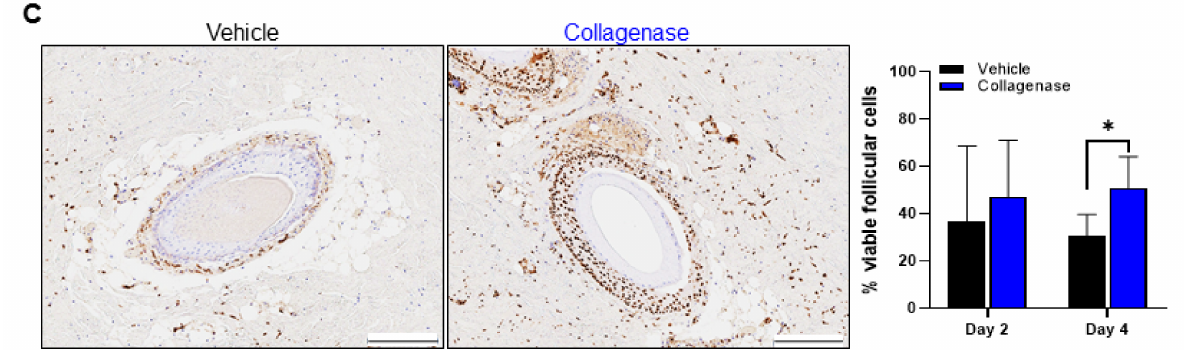
Figure 3. Collagenase-treated burns limit necrosis. HMGB1 staining pattern in porcine burn interspaces for various days in wounds treated with vehicle and collagenase hydrogels. ( A ) Tissue biopsy from day 0 shows the border between positive and negative staining for HGMB1, indicated by the red dotted line. Left panel: black arrows indicate the wound edges with normal skin, including normal dermis and epidermis present in burn interspace of the tissue section, and black bar represents 500 µ m. Right panel: a horizontal strip was selected along the epidermal–dermal junction of the wound and divided into three magnified images from left to right (from yellow, to green, and to red dashed border) to visualize the specific staining patterns observed. ( A , yellow) Image showing all viable tissue with strongly positive nuclear HMGB1 staining. ( A , green) Diffuse cytosolic and extracellular HMGB1 staining released from necrotic cells. ( A , red) The dermis directly under burn wound is observed to not have any positive HMGB1 staining and all nuclei are only stained blue. Black scale bars in yellow, green and red stained images represent 100 µ m. ( B ) HMGB1 staining pattern of wound interspace sections on days 2 and 4 for vehicle and collagenase treatments. Collagenase treatment showed HMGB1 staining pattern with significantly more nuclear HMGB1 stain, indicative of preserved cell viability, relative to treatment with vehicle that showed diffuse extracellular and cytoplasmic HMGB1 staining, indicating expansion of the burn zone in vehicle-treated burns. Black scale bars represent 200 µ m. Percent (%) extranuclear HMGB1 was calculated from the total number of positive nuclear HMGB1/total cells as shown by hematoxylin blue stain × 100%. Values represent mean of 4 biopsies per time point and per treatment ( n = 4) ± SD. ** p < 0.01; *** p < 0.001. ( C ) HMGB1 staining pattern of hair follicles in the wound interspace sections on day 4 for vehicle and collagenase treatments. A diffuse extracellular and cytoplasmic HMGB1 staining along with complete absence of stain is shown for vehicle-treated wounds, while treatment with collagenase shows significantly greater strongly positive nuclear HMGB1 staining. Black scale bars represent 200 µ m. Percent (%) viable follicular cells was calculated from the total number of positive nuclear HMGB1 follicular cells/total follicular cells as shown by hematoxylin blue stain × 100%. Values represent mean of 4 biopsies per time point and per treatment ( n = 4) ± SD. * p <